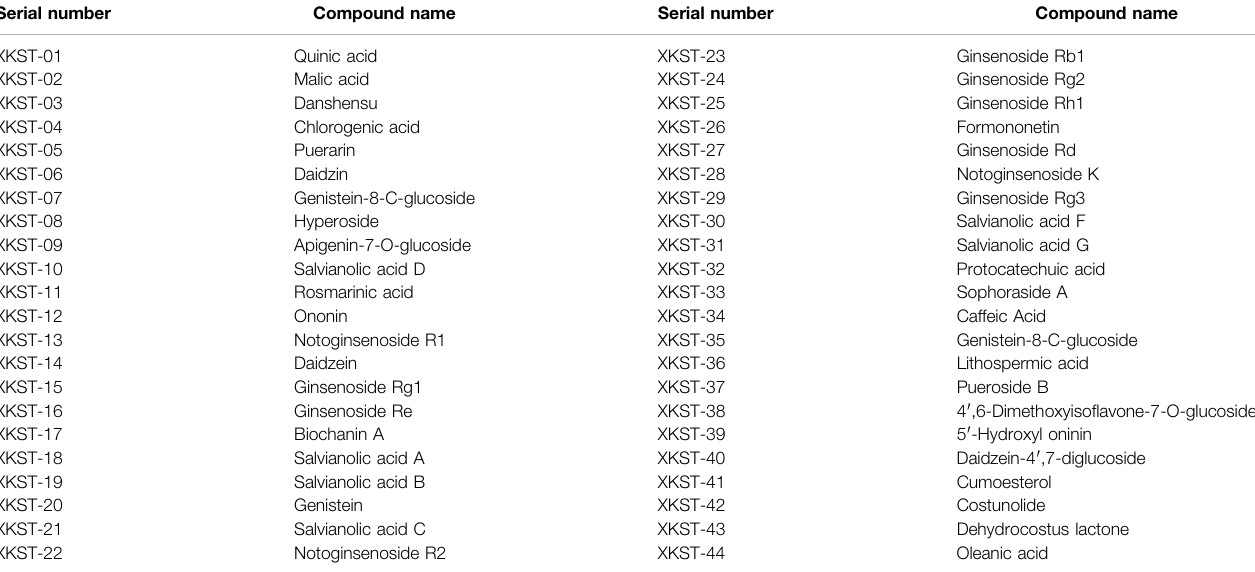
TABLE 3 | Forty-four anticardiovascular disease components of XKST identi fi ed by network